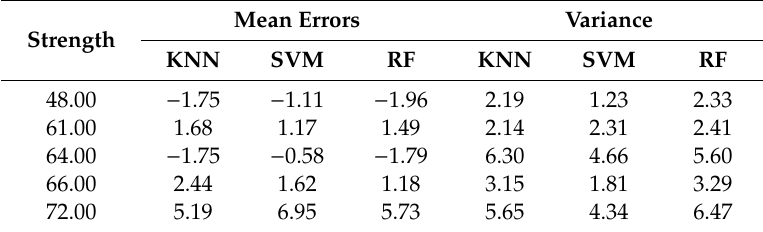
Table 4. Regression results of Batch